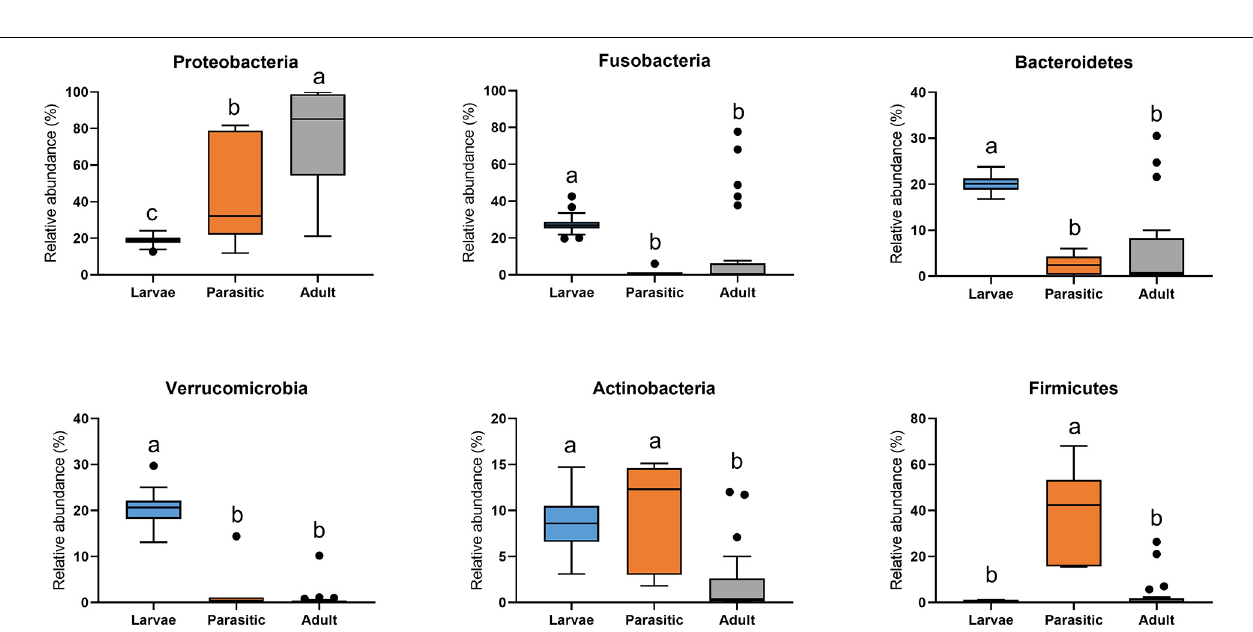
FIGURE 3 | Phylum-level classification of microbial communities associated with larval, parasitic, and adult sea lamprey ( Petromyzon marinus ). All taxa present in ≥ 5% relative abundance in an individual SL are shown in this graph; significant differences ( p < 0.05) illustrated by different letters above bars.